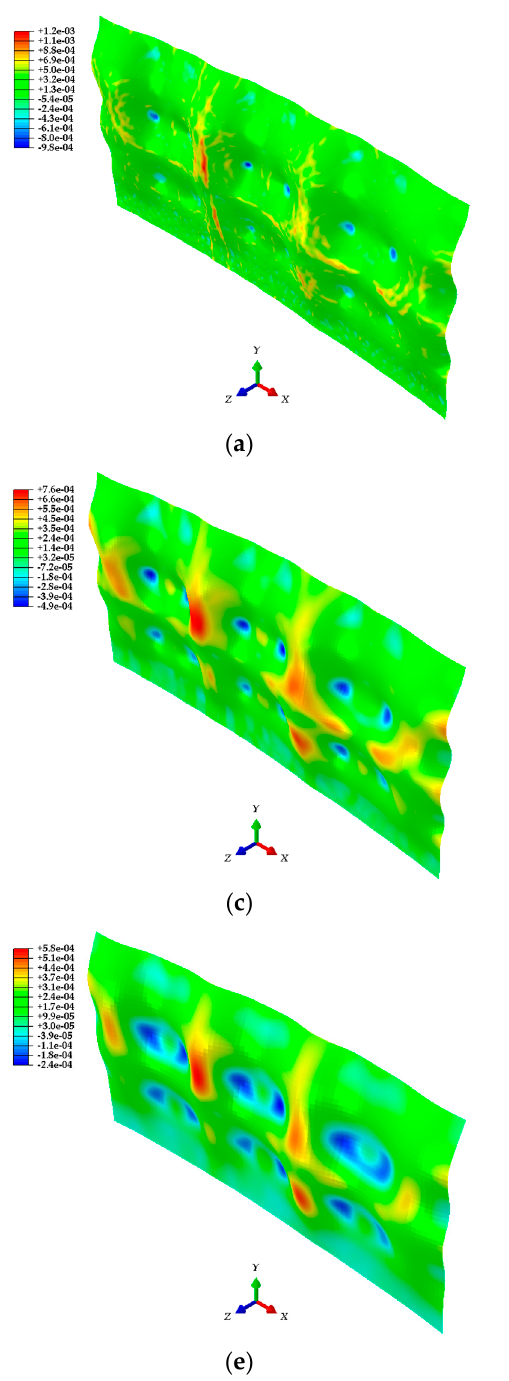
Figure 16. Finite element models showing the strain distribution for: ( a ) Case 1 (30 × 30); ( b ) Case 2 (40 × 40); ( c ) Case 3 (50 × 50); ( d ) Case 4 (60 × 60); ( e ) Case 5 (80 × 80); ( f ) Case 6 (100 ×